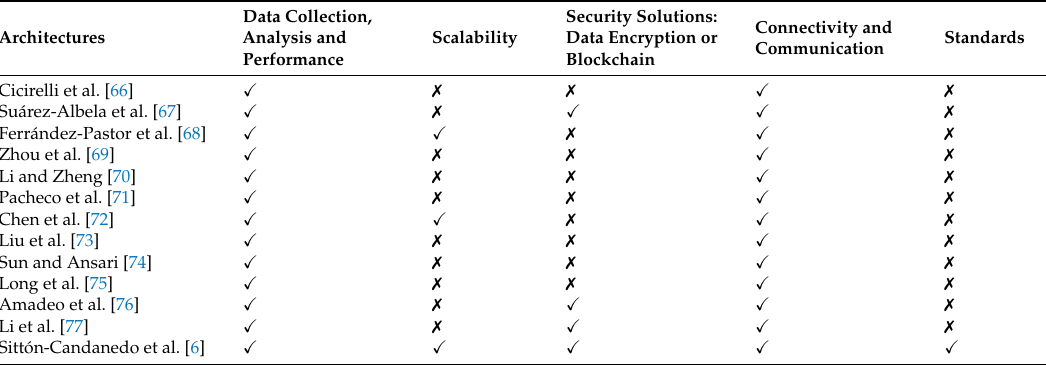
Table 3. Comparison of the main characteristics of the architectures. The check-mark ( (cid:88) ) means advantages and x-mark ( (cid:55) ) means